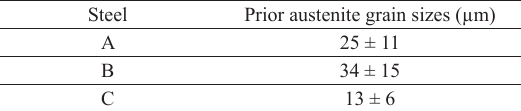
Table 3. Prior austenite grain sizes measured for steels A, B and C.